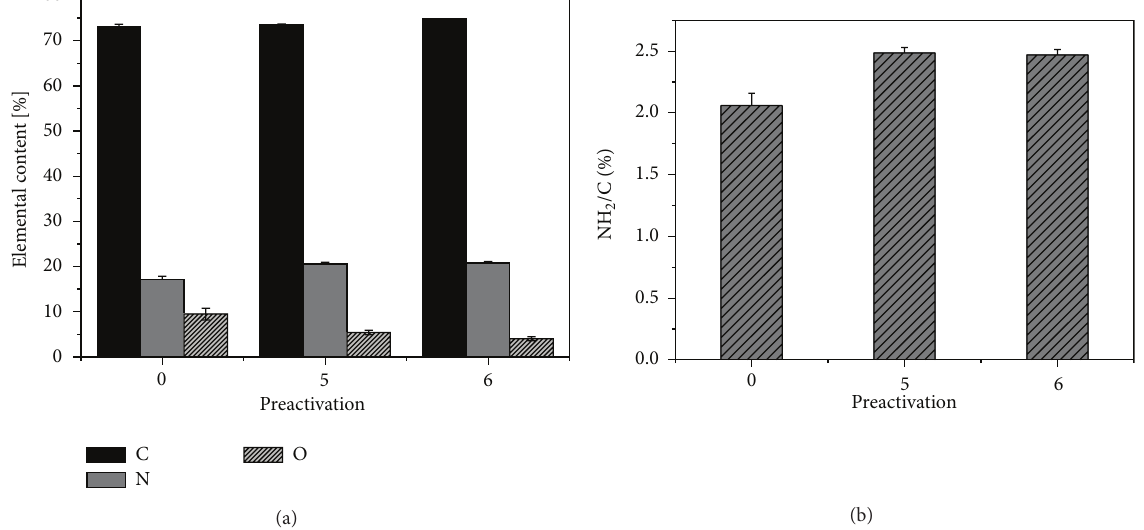
Figure 6: XPS investigations ((a) elemental composition and (b) NH 2 /C ratio) of PPAAm-coated PLA fiber meshes without plasma preactivation and with plasma preactivation (methods 5 and 6),